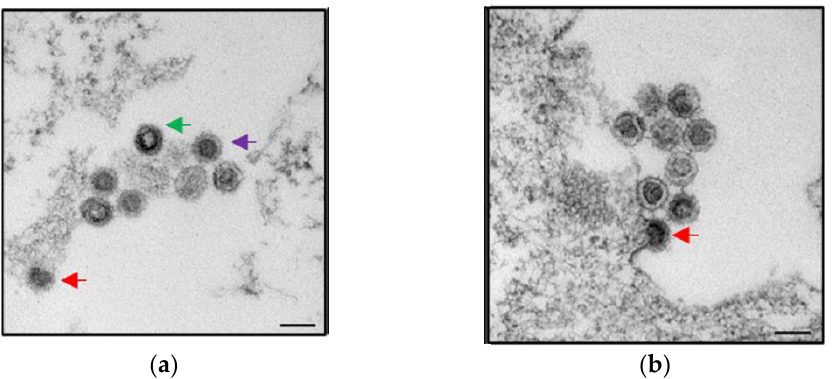
Figure 3. Two electron microscopic pictures ( a , b ) of recombinant PERV-A/C particles produced by human 293 cells. The virus was isolated from PBMCs of a Göttingen minipig and was able to infect 293 cells [59]. Budding viruses (red arrow), maturating viruses (green arrow), and mature viruses (lilac arrow) can be seen. Bar — 200 nm. Courtesy of L. Möller and M. Laue, Robert Koch Institute, Berlin.